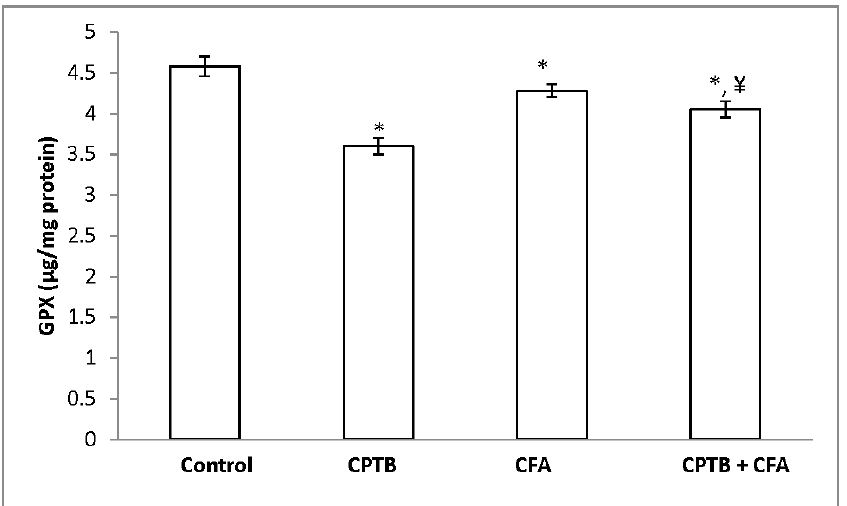
Figure 2. Protective effect of caffeic acid on the reduction of glutathione peroxidase (GPx) levels in rats due to capecitabine-induced toxicity. Data are expressed as means ± SD for six rats in each group; * significantly different from the control ( p < 0.05); ¥ significantly different from the capecitabine group ( p < 0.05).